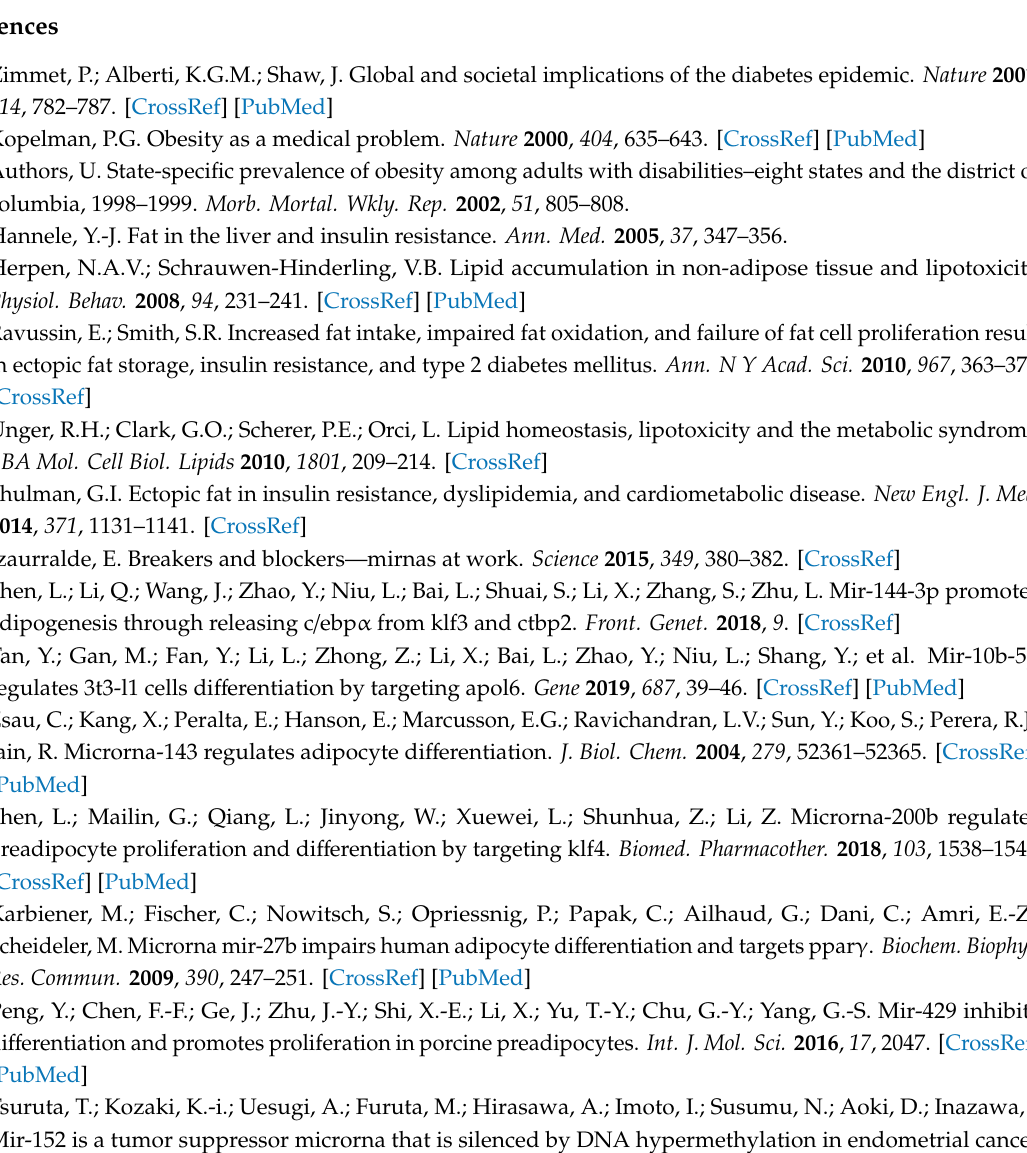
Supplementary Materials: The supplementary materials are available online, Table S1: Sequences of PCR primers used in this